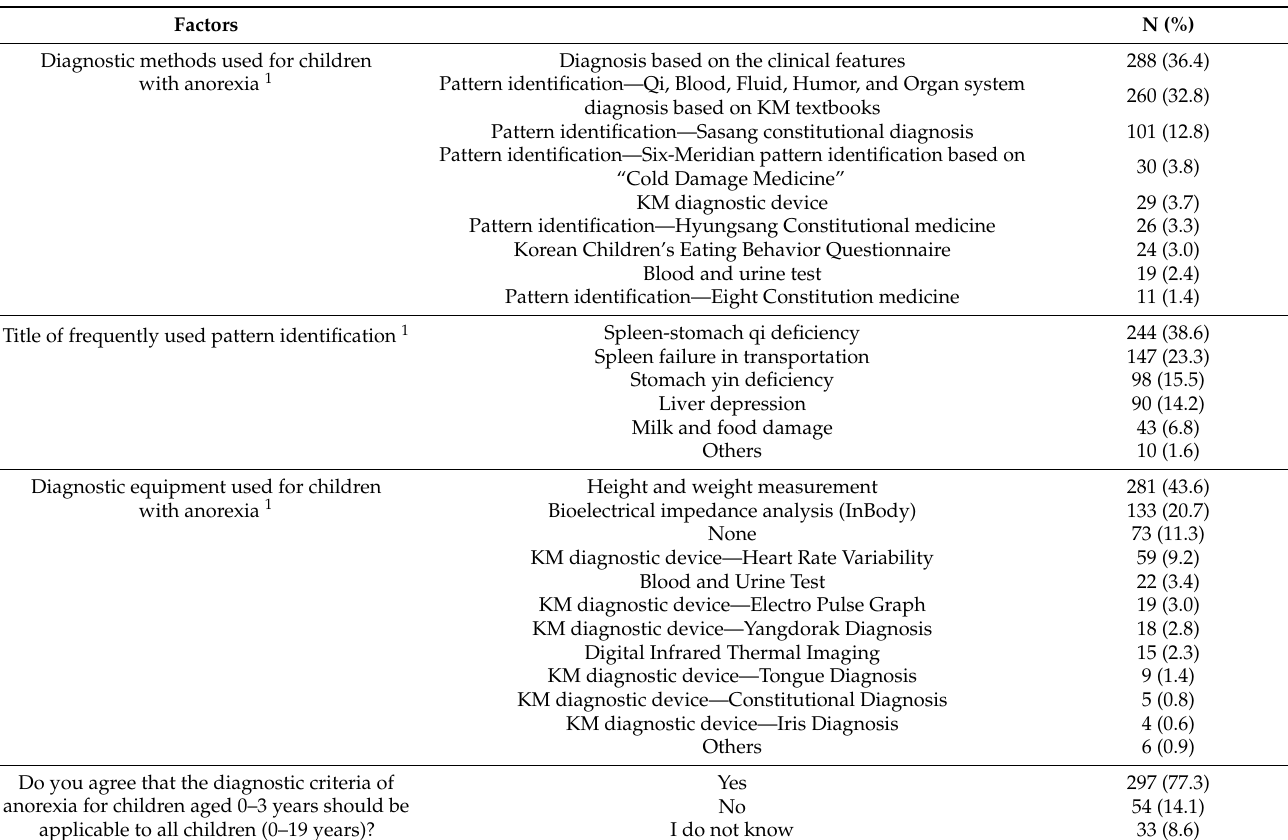
Table 2. Diagnosis of anorexia in children (N =